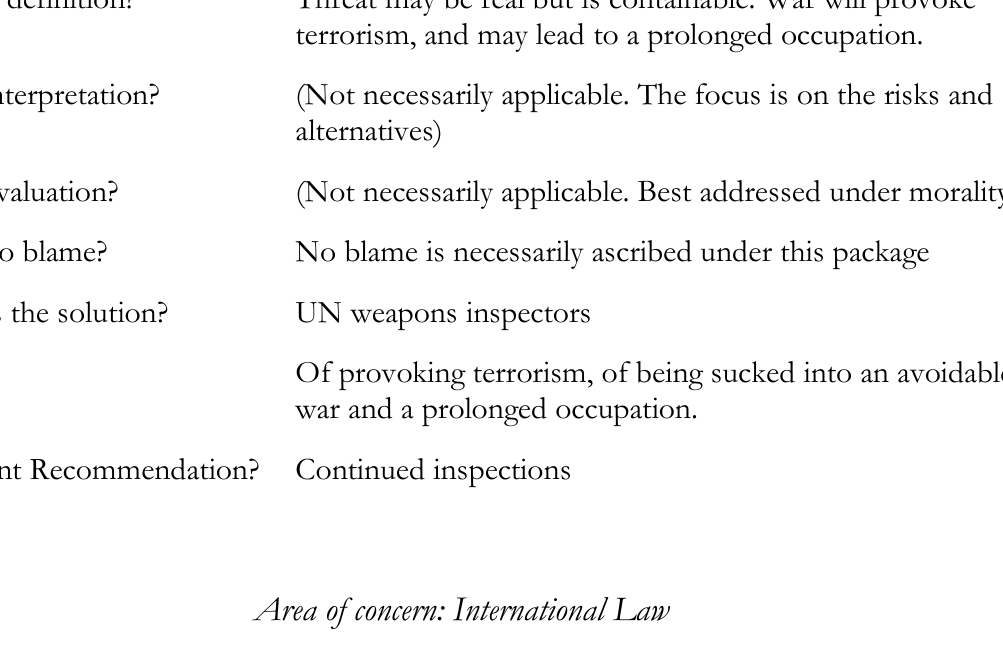
Fig 2: Antiwar security Problem definition? Threat may be real but is containable. War will provoke terrorism, and may lead to a prolonged